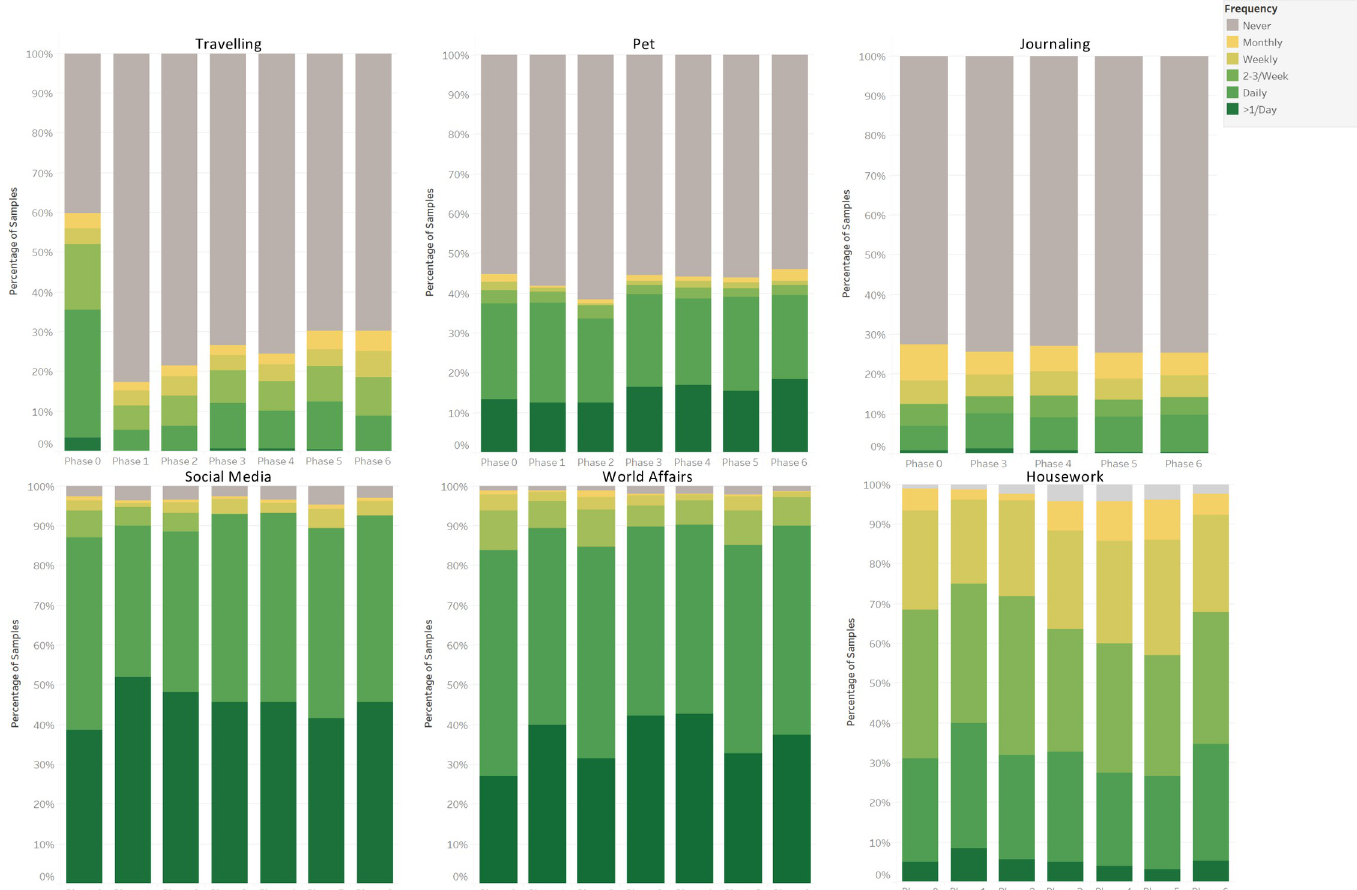
Fig 4. Stacked bar showing the frequency changes of six activities across 7 phases; P-value has been calculated by Chi-square goodness of fit test.